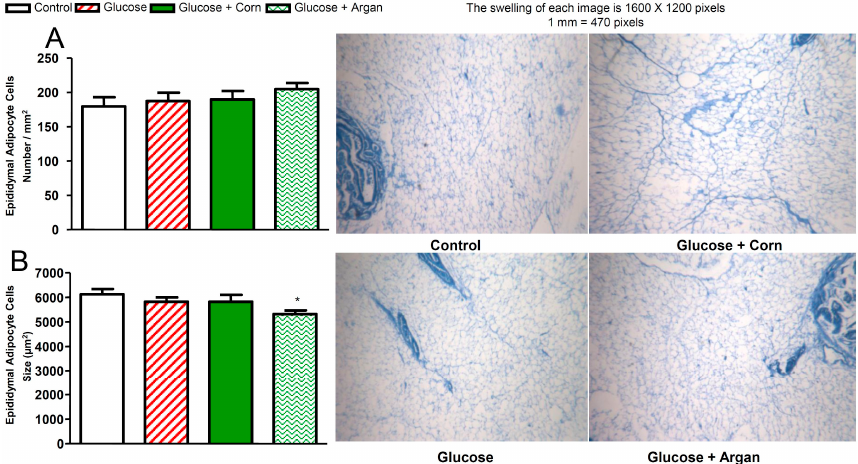
Figure 4. Effects of 12 weeks of glucose feeding combined or not with orally and daily administered (5 mL·kg − 1 ) corn oil or argan oil on ( A ) epididymal adipocyte cells number expressed in number/mm 2 and ( B ) epididymal adipocyte cells size expressed in µm 2 . Values are the mean ± SEM of four rats per group.* p < 0.05 vs. control. Histology of the adipose tissue pad is also shown for each group.